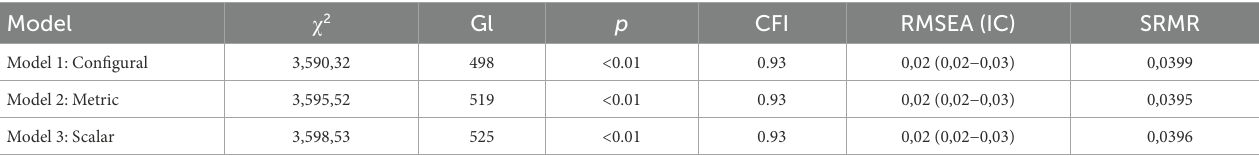
TABLE 2 Indicators produced by the multi-group confirmatory factor analysis for factorial invariance tests between sex (RS, 2013–2018; n = 4.681). Model